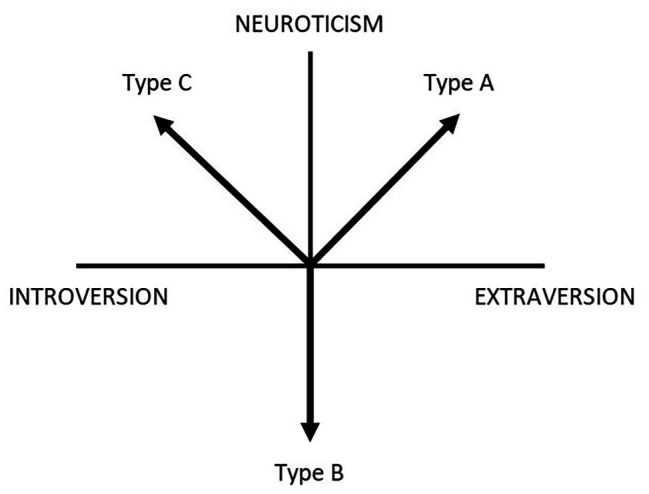
Hypothetical relations of Types A, B, and C to extraversion and neuroticism (Eysenck, 1991).